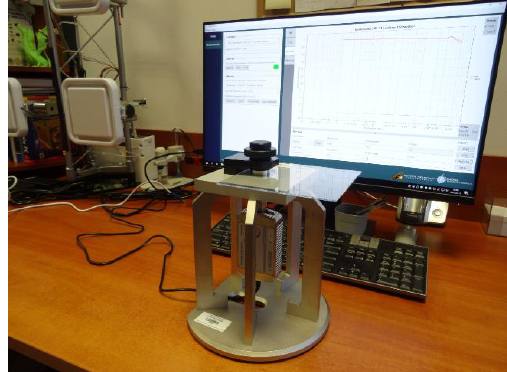
Figure 4. Laboratory stand of complex permittivity measurement.